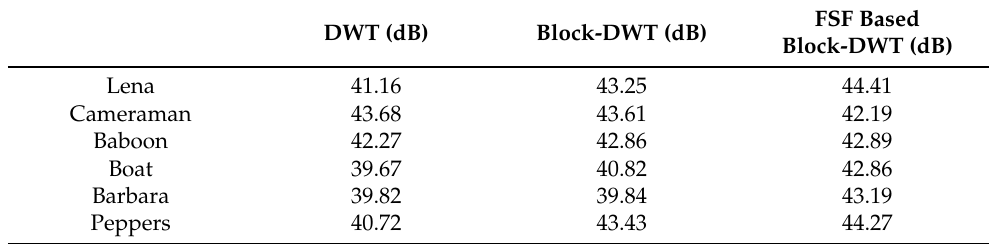
Table 1. Peak signal to noise ratio (PSNR) values after embedding binary image to the cover